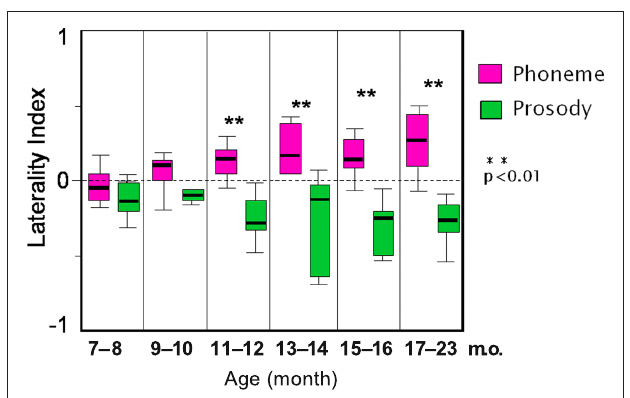
FIguRe 1 | Box-whisker plot of laterality index (LI) for phonemic and prosodic conditions in different age groups. A LI relies upon the formula (L − R)/(L + R), where L and R are the maximal total Hb changes in the left and right auditory channels, respectively. LI is above zero for left dominance and below zero for right dominance. * = p < 0.05. Boxes, The quartiles; bars in the box, the medians; hinges, the ranges. This is adapted from Sato et al. (2003)